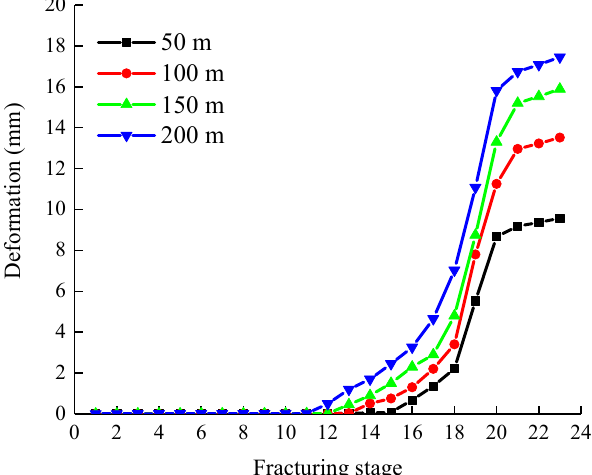
Figure 15. Influence of fault length on casing deformation.